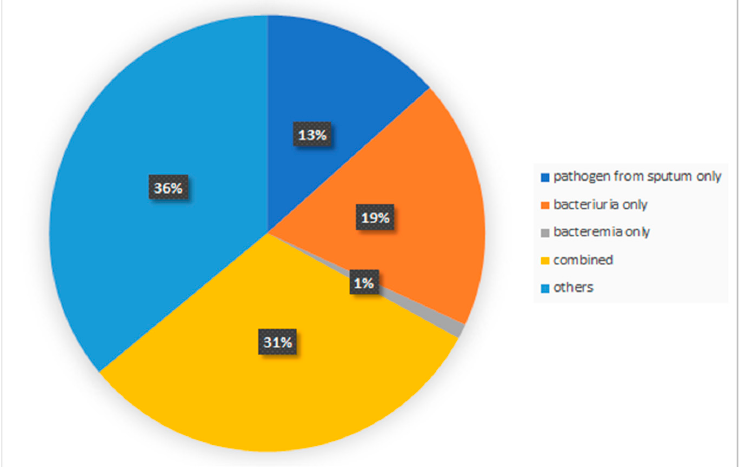
Figure 2. Proportions of post-stroke infection accounted for by positive culture results, where cases in which two or more positive pathogens from respiratory, genitourinary or blood samples tested positive were categorized as “combined.” In contrast, positive pathogens from other sources with elevated white blood cell counts with records of intravenous antibiotic treatment and were categorized as “others”.